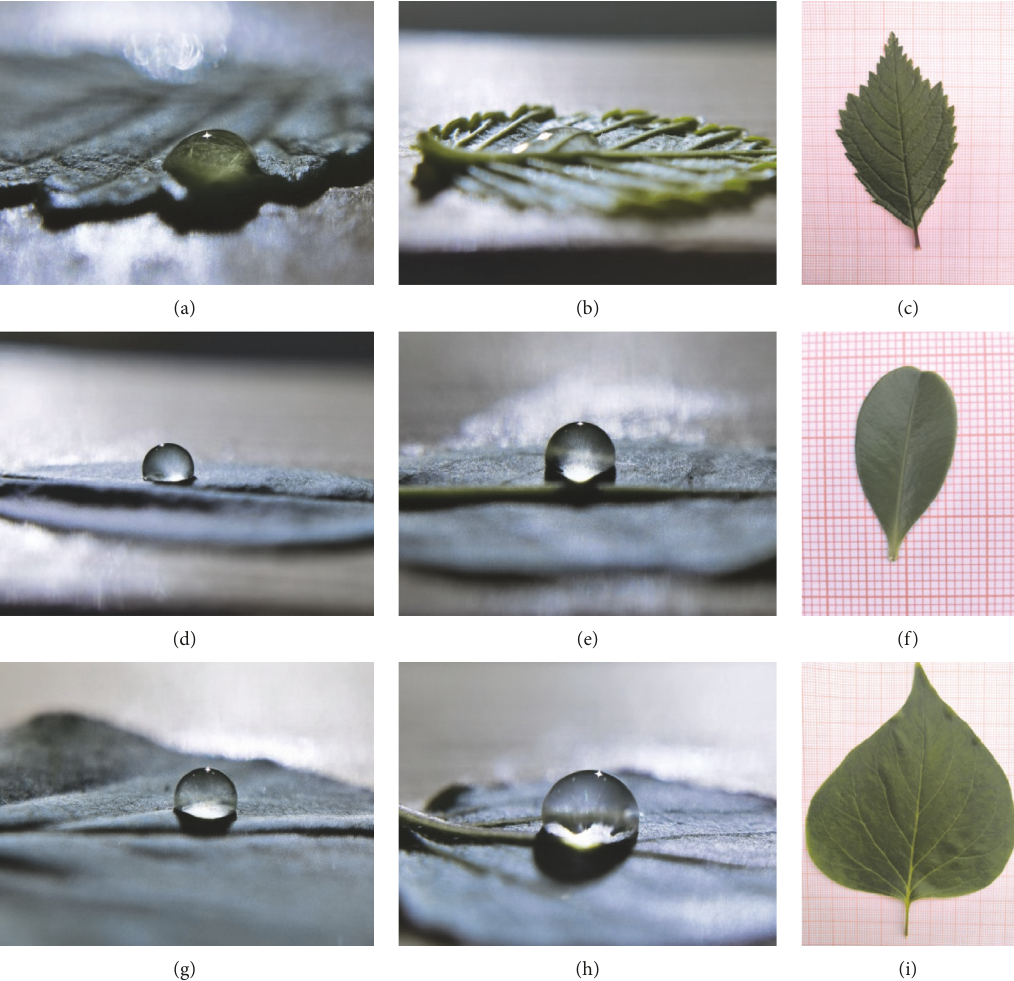
Figure 7: Drop contact angle (DCA) and leaf morphology of different species. (a) DCA of the Hemiptelea adaxial surface; (b) DCA of the Hemiptelea abaxial surface; (c) photograph of the Hemiptelea leaf; (d) DCA of the Buxus adaxial surface; (e) DCA of the Buxus abaxial surface; (f) photograph of the Buxus leaf; (g) DCA of the Syringa adaxial surface; (h) DCA of the Syringa abaxial surface; (i) photograph of the Syringa